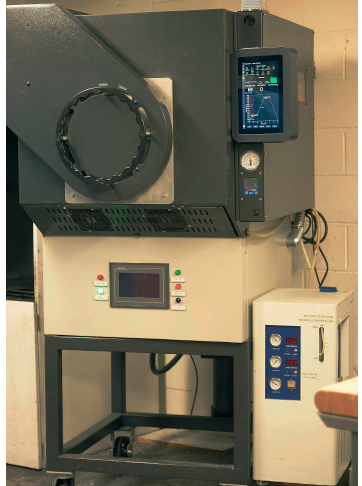
Figure 1. Application of the slurry: ( a ) Weighting the deposit ( b ) Sample coated, dried, and rolled.